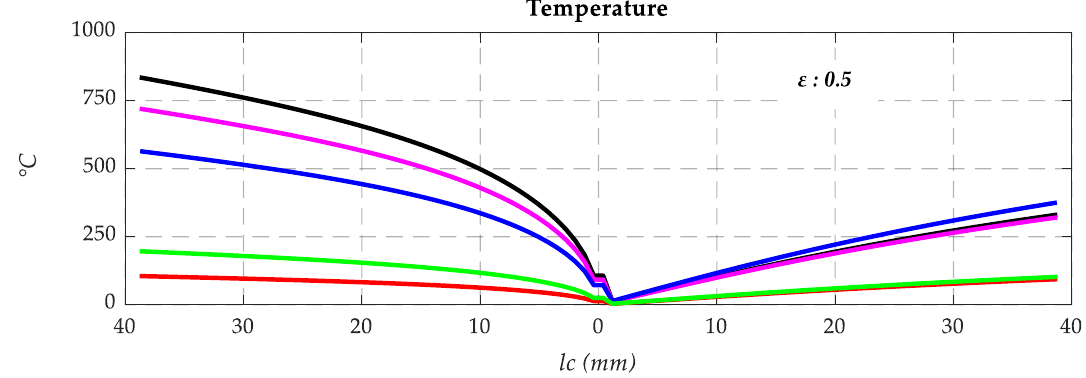
Figure 6. Temperature distribution over the contact length.